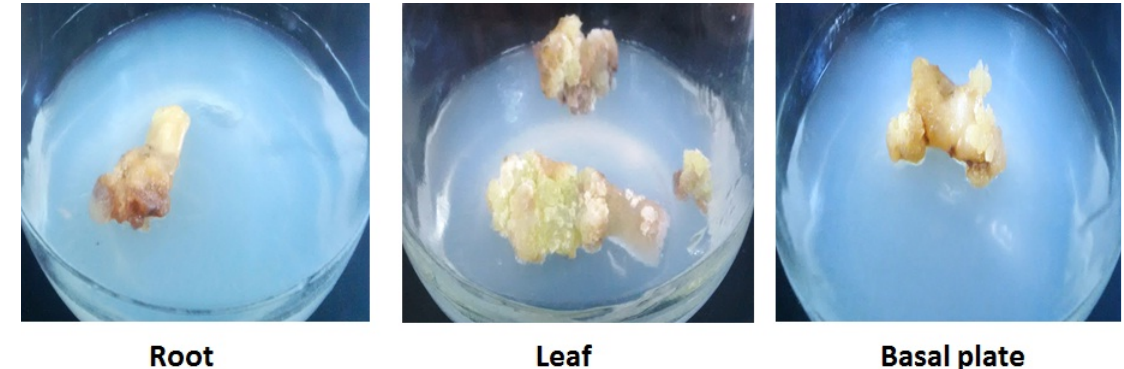
Fig. 3 Callus proliferation on MS medium supplemented with methyl jasmonate after harvesting proliferated friable biomass from medium supplemented with 2,4-D (1 mg L −1 ) for callus formation.